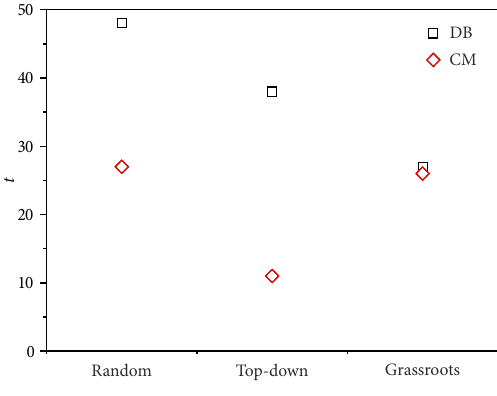
Figure 11. Cascade effect is influenced by the role of